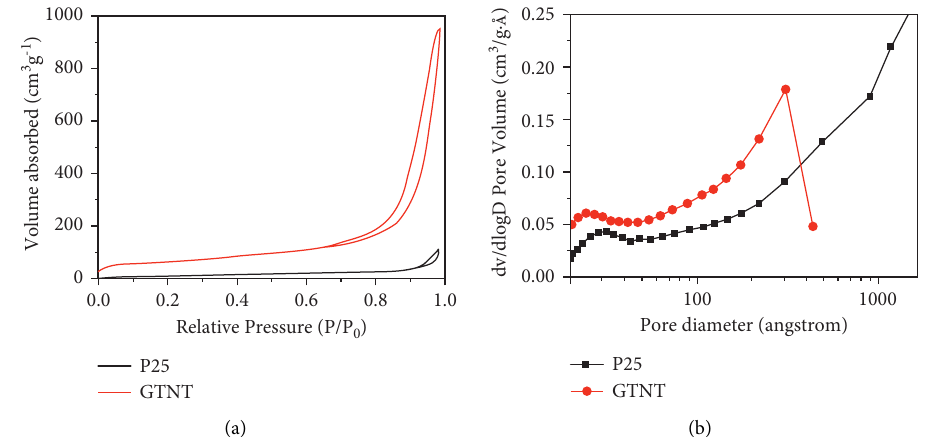
Figure 7: (a)-(b) The nitrogen adsorption-desorption isotherm and BJH pore size distribution curve of the GTNT composites and